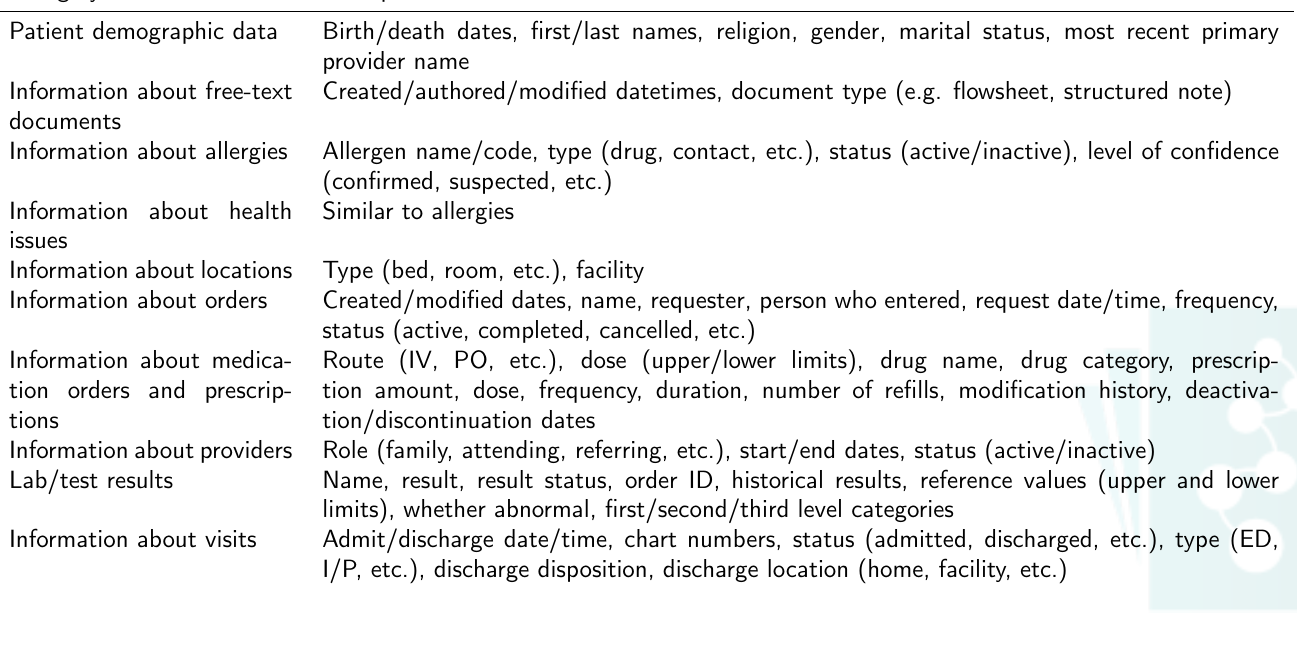
Table 1: Example Elements of Entered Structured